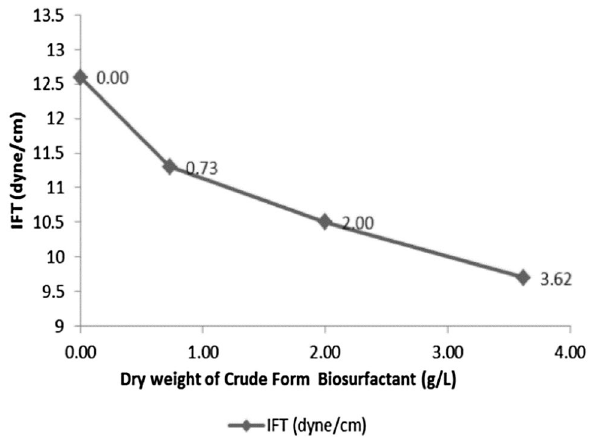
Fig. 1 CMC curve of isolate